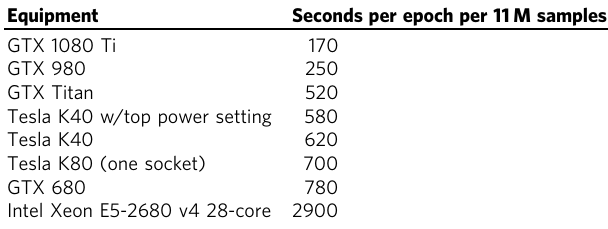
Table 1 Time per epoch of different models of GPU and CPU in model